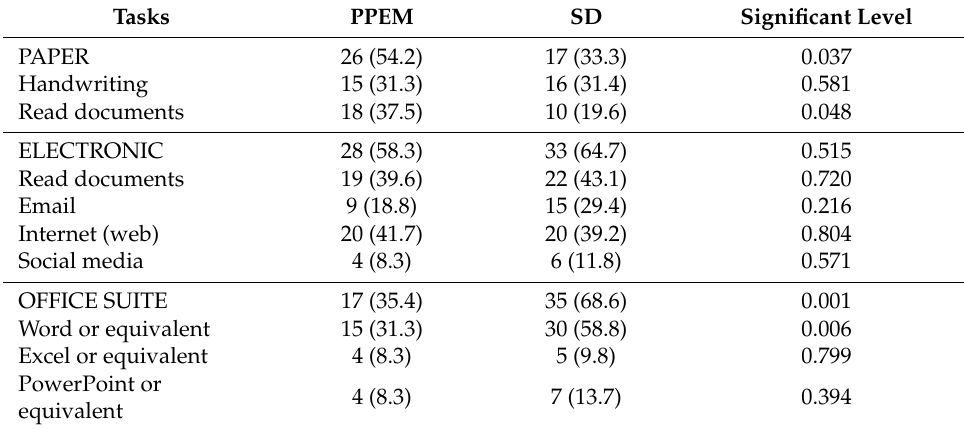
Table 1. Tasks made by the participants according to the active workstation used.